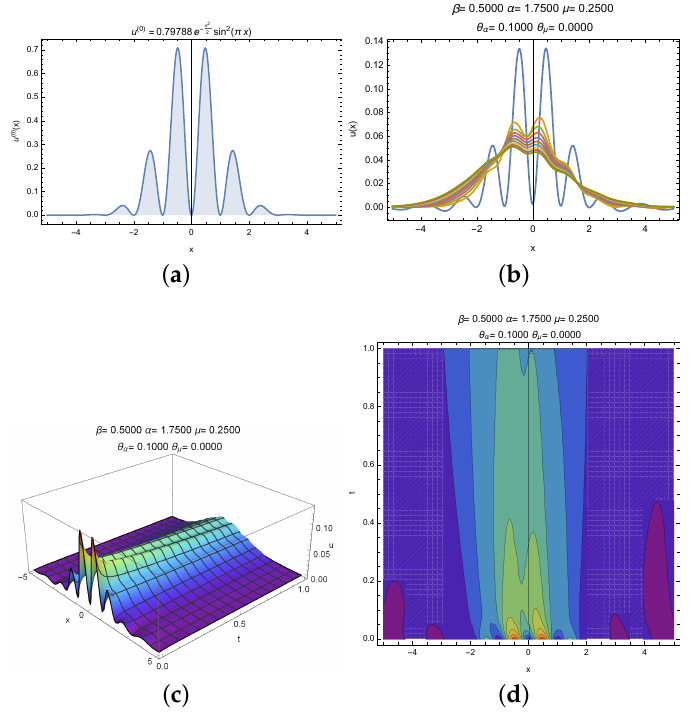
2 2 sin 2 ( π x ) . The